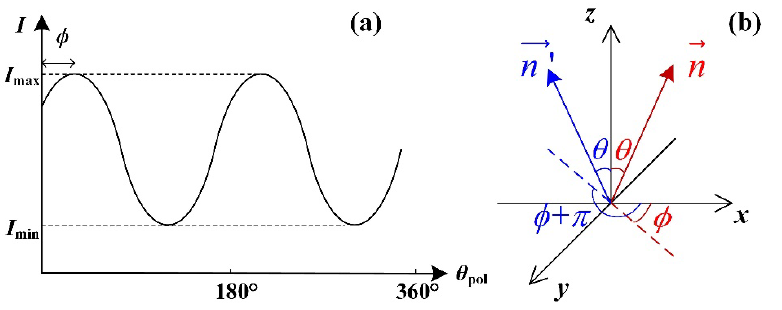
Figure 2. ( a ) Sinusoidal nature of reflected partially polarized light through a linear polarizer as a function of polarizer orientation; ( b ) illustration of ambiguous normal.